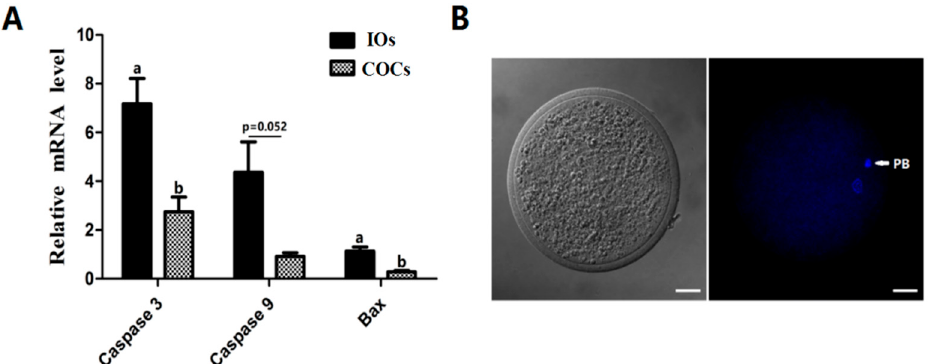
Figure 1. The relative mRNA expression of caspase-3 , -9 , and Bax in IOs and COCs. ( A ) Relative mRNA expression of caspase-3 , -9 , and Bax in IOs and COCs. IOs: inferior oocytes; COCs: cumulus-oocyte complexes. n = 3. a,b Values of different superscripts indicate significant difference ( p < 0.05); ( B ) Nuclear staining after IVM. PB: polar body, scale bar = 20 µ m. Table 1. The effect of melatonin on the nuclear maturation of bovine oocytes. Groups